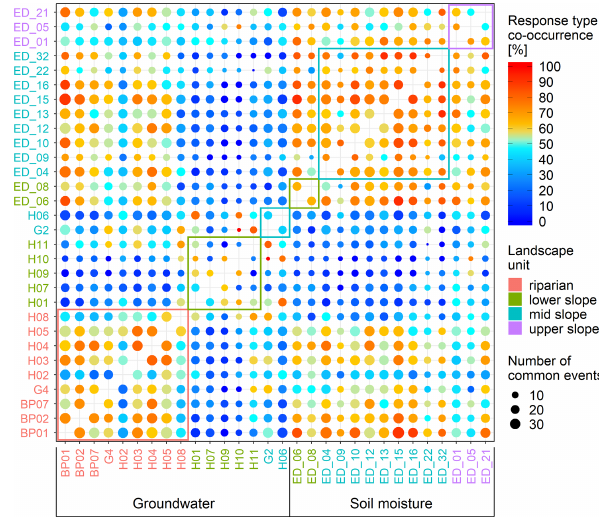
Figure 11. The frequency of events when two stations have the re- sponse of the same type – i.e. response-type co-occurrence. The size of circles corresponds to the number of events when both sta- tions had a response. Circles’ colour corresponds to the frequency of the response-type co-occurrence. The station names’ colour cor- responds to their landscape unit. Coloured rectangles enclose values of stations in the same landscape